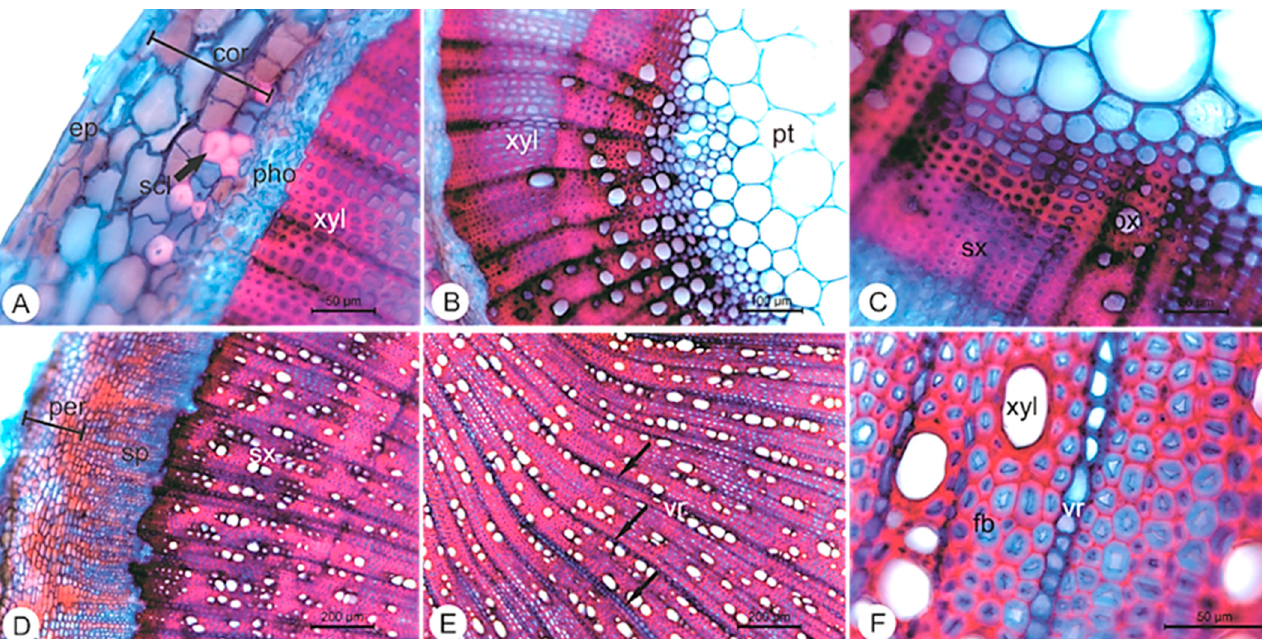
Figure 3. Cross sections of stem of Elsholtzia ciliata (Thunb.) Hyl. ( A ) Stem primary growth, with uniseriate epidermis; ( B ) Detail of vascular tissue and a parenchyma pith; ( C ) Detail of xylem; ( D ) Stem secondary growth, with secondary vascular tissue and several layers of periderm; ( E ) Detail of secondary vascular tissue divided by parenchyma rays; ( F ) Detail of xylem tissue with fibers. Legend: cortex (cor); epidermis (ep); fibers (fb); periderm (per); phloem (pho); pith (pt); primary xylem (px); sclereids (scl); secondary phloem (sp); secondary xylem (sx); vascular ray (vr); xylem (xyl).